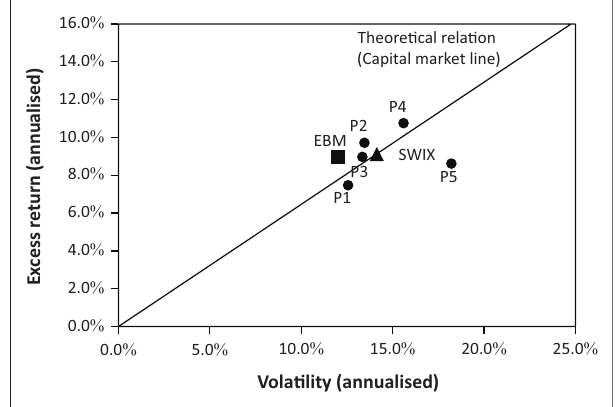
FIGURE 1: Beta sorted portfolios and the capital market line.